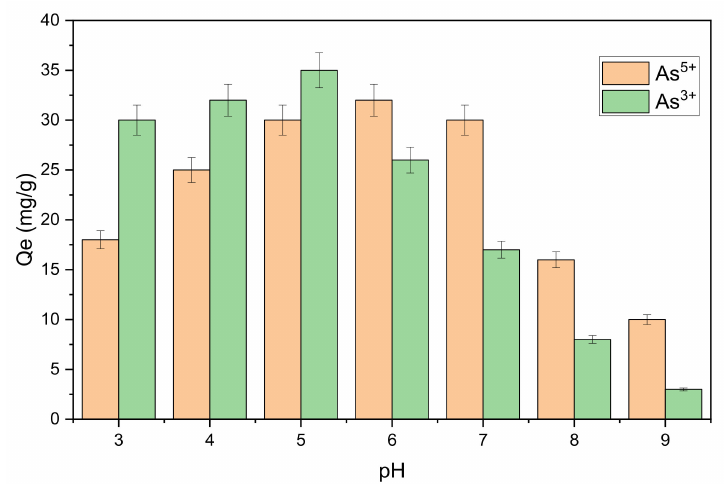
Figure 10. Effect of pH on As 3+ and As 5+